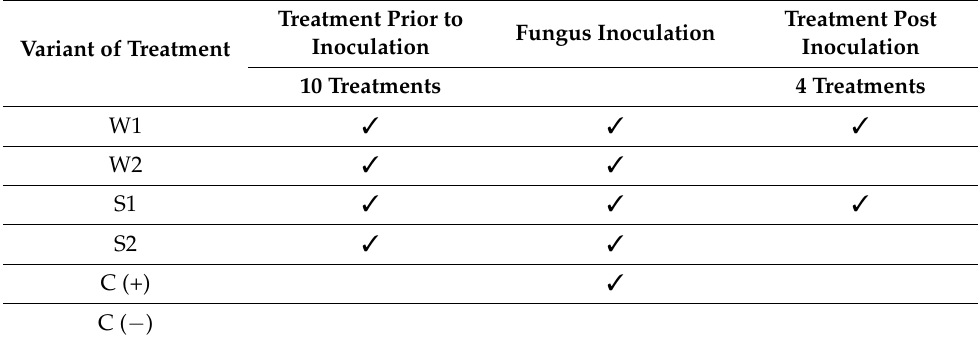
Table 1. The variants of treatment in the experiment and simplified schedule of treatment.